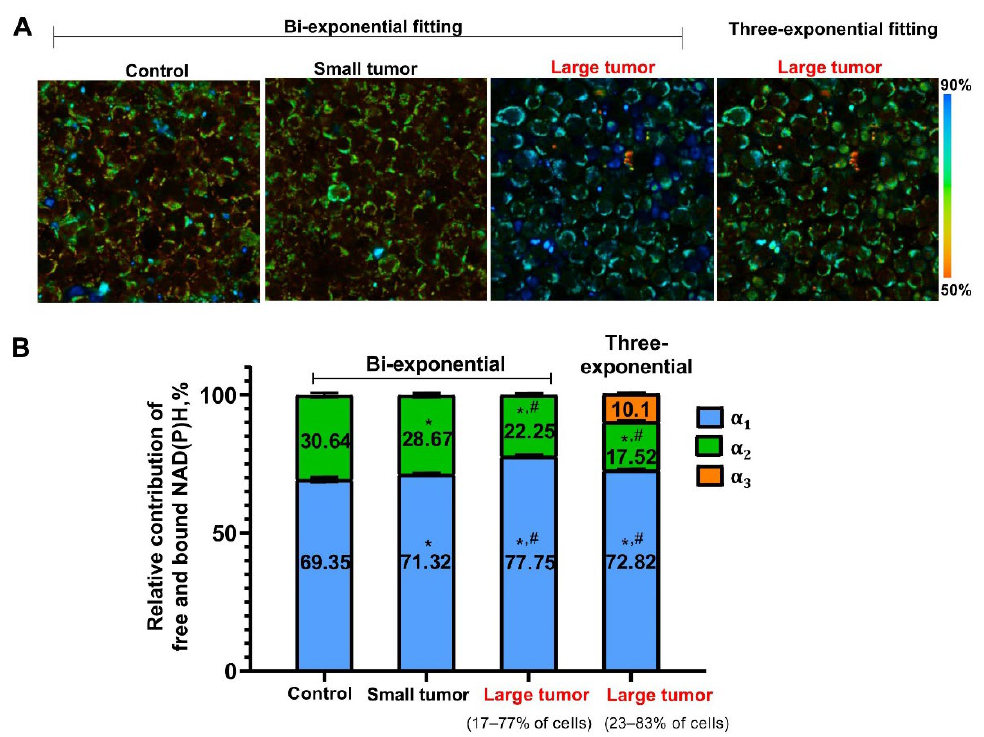
Figure 3. Relative contributions of NAD(P)H in LNs of intact and tumor-bearing mice. ( A ) Representative FLIM images of the relative amplitude of free NADH α 1 , upon bi- (all groups) and three- (“Large tumor” group) exponential fitting. ( B ) Quantification of relative contributions of free and bound NADH ( α 1 , α 2 ) and NADPH ( α 3 ). The data are presented as mean ± SEM. * p < 0.03, compared to “Control” group; # p < 0.0001, compared to the “Small tumor” group. Three-exponential fitting was applied to the part of cells (28–83 %) having long lifetime τ 2 within each LN; other cells were processed with bi-exponential fitting.